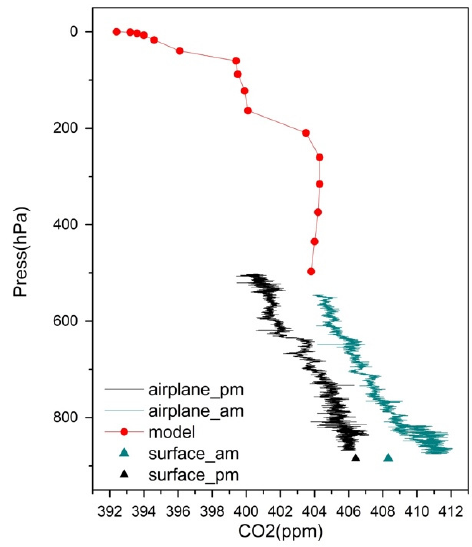
Figure 8. Combined CO 2 profile observed on 27 April 2017 over the Dunhuang calibration field. Black and green dots are the aircraft (in situ) data and the ground-based GGA data, respectively, obtained near the TanSat overpass time. The red line shows the CT modelled profile.